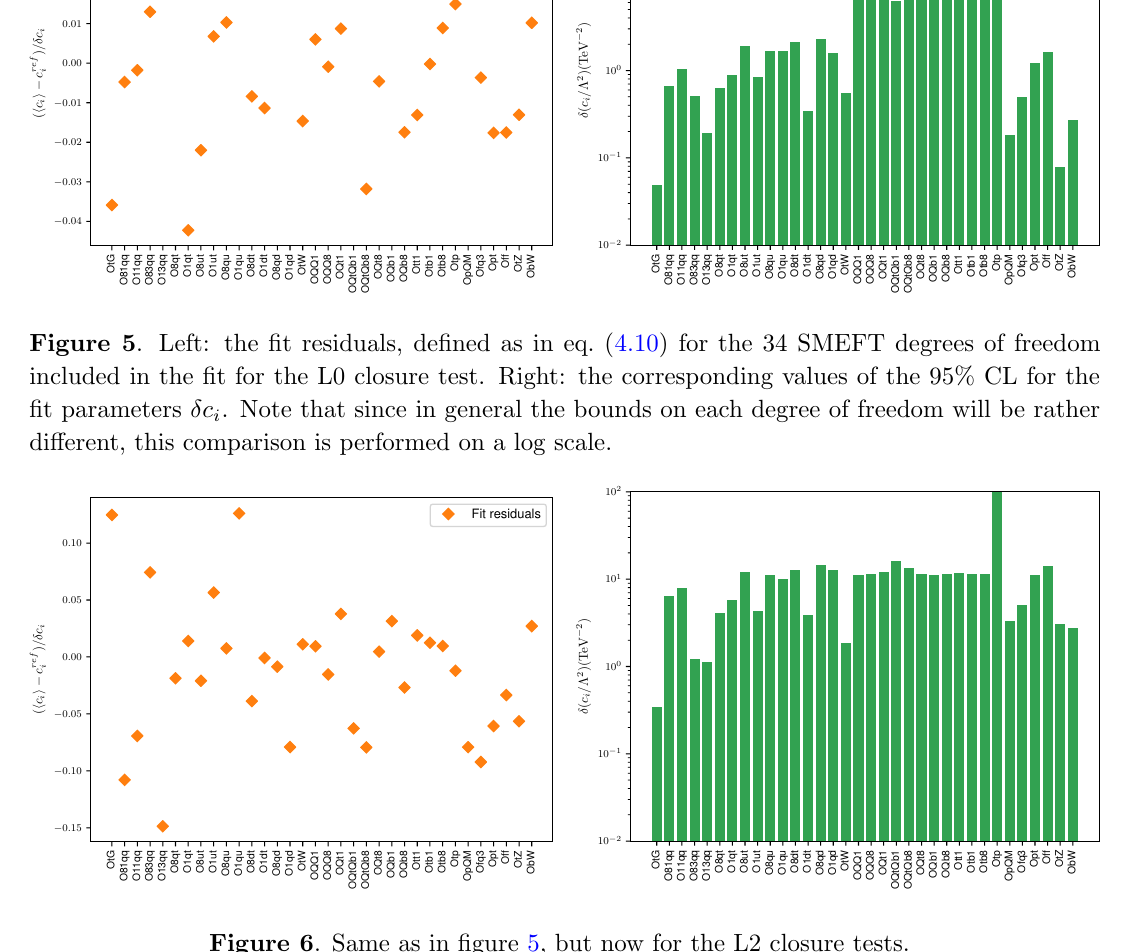
Figure 6 . Same as in (cid:12)gure 5, but now for the L2 closure